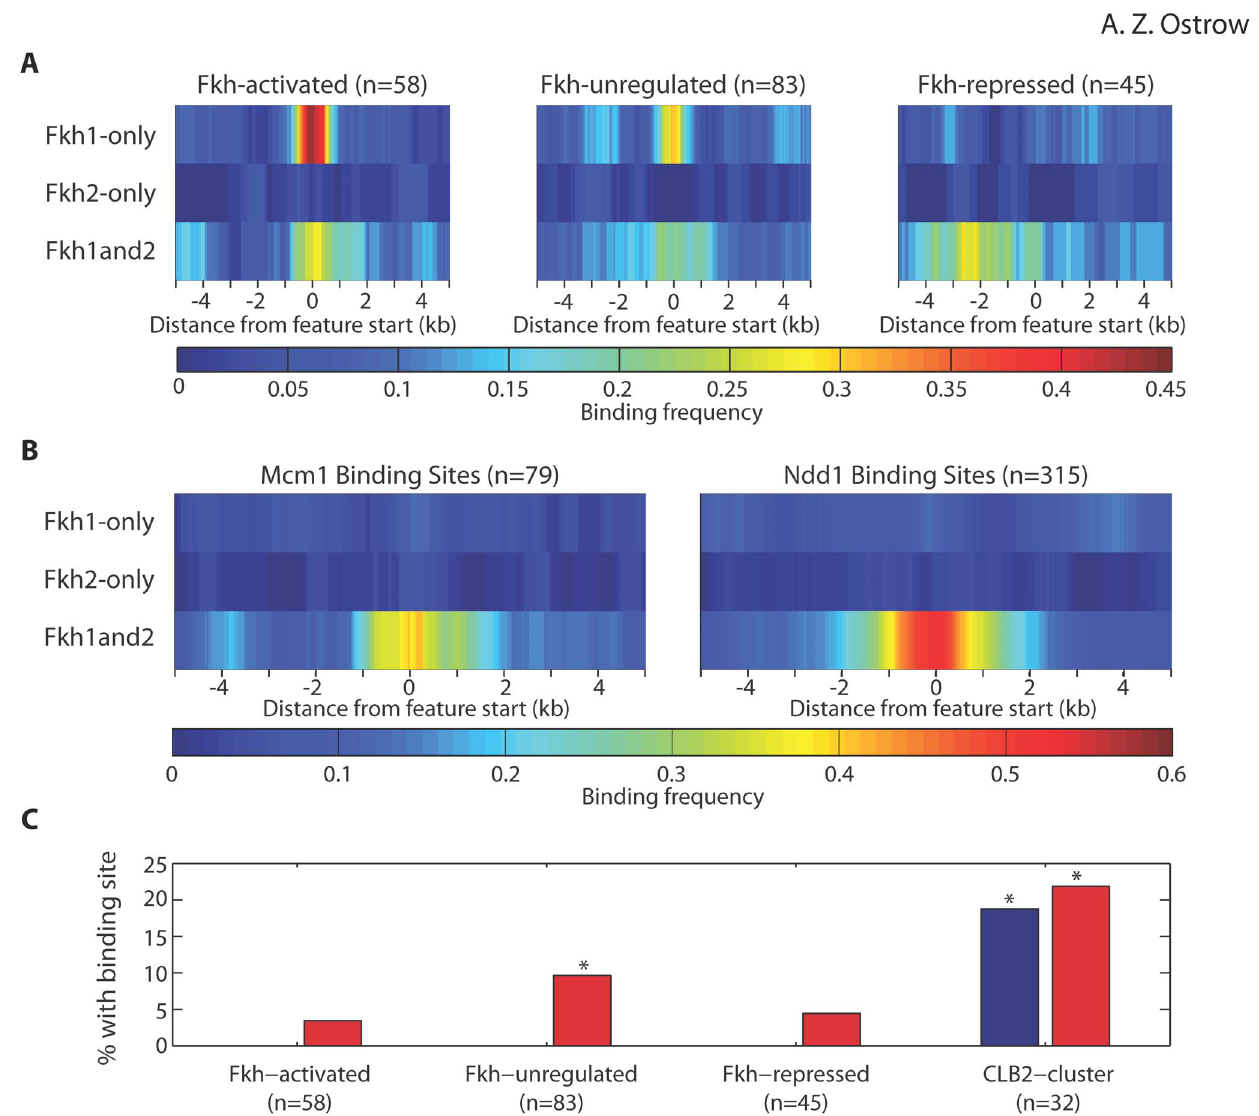
Figure 5. Fkh1 and Fkh2 binding with replication origins. ( A–B ) Heat maps show 10 kb regions of summed binding data for the indicated types of binding loci (e.g.: Fkh1-only, Fkh2-only, Fkh1and2) surrounding the groups of features indicated above the heat map. The color represents the frequency of enriched binding sequences called for each group of features, amongst total number of features (n) included in each group. A ) Fkh1 and Fkh2 enrichment frequencies surrounding Fkh-activated, Fkh-unregulated, and Fkh-repressed origins are plotted with each group aligned and oriented at coordinate 0 by each origin’s ARS consensus sequence (ACS). B ) Fkh1 and Fkh2 enrichment frequencies are plotted around Mcm1 and Ndd1 binding sites, which are aligned and oriented by Mcm1 and Ndd1 consensus sequences, respectively. C ) The graph shows the percentage of each element class having an Mcm1 or Ndd1 binding site within 500 bp. Asterisks indicate values significantly greater than expected on a random basis at p , 0.01 (see Methods